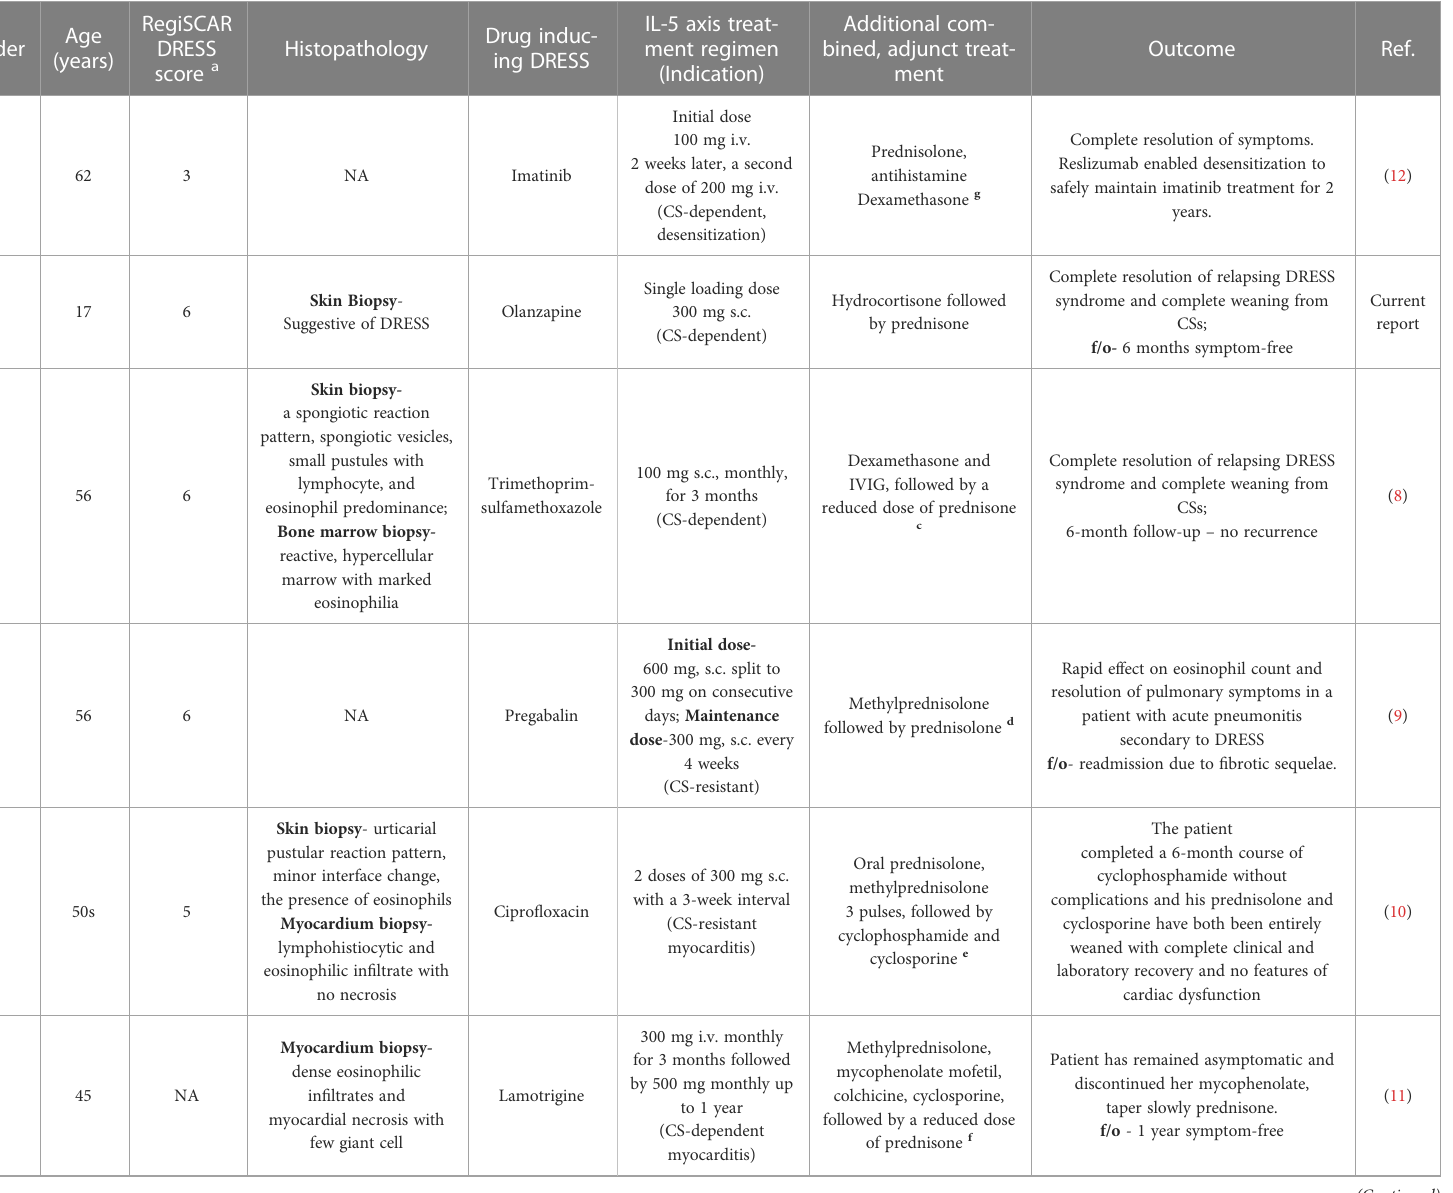
TABLE 2 Clinical characterizations of the DRESS patients treated off-label with monoclonal antibodies of the IL-5 axis.